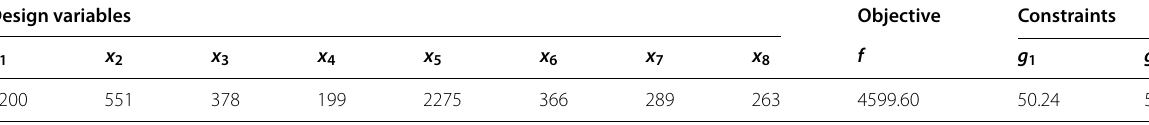
Table 4 The optimum solution provided by DADOS for the engineering case Design